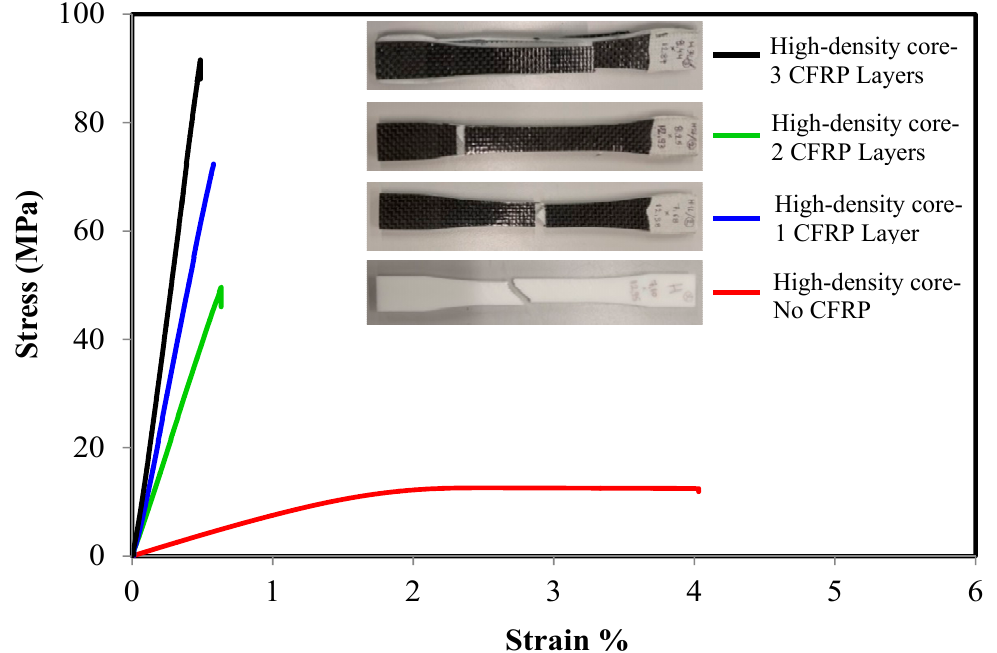
Figure 6. Typical tensile stress-strain response of high-density core CFRP/ABS/CFRP composite samples.